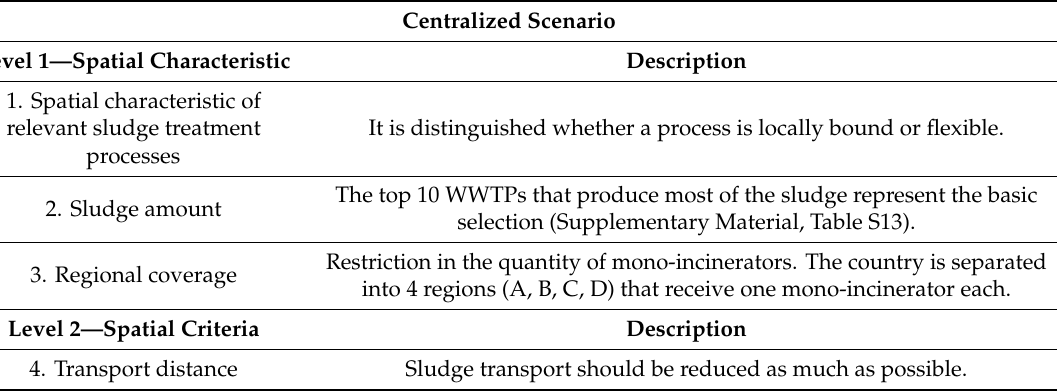
Table 5. Assumptions for the development of a centralized scenario divided in levels 1 and